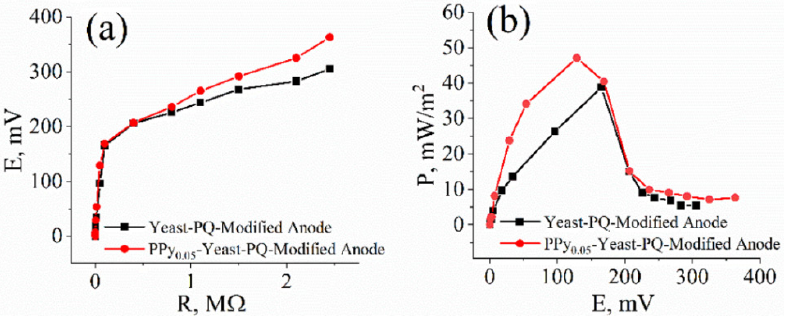
Figure 7. ( a ) Dependence of potential on the applied external load. ( b ) Calculated dependence of power density on the generated potential in the double-compartment-based MFC, which consisted of (1) a PPy 0.05 –yeast–PQ-modified anode and (2) a bare graphite cathode immersed in the phosphate buffer solution containing 0.75 mM potassium ferricyanide and 30 mM glucose.